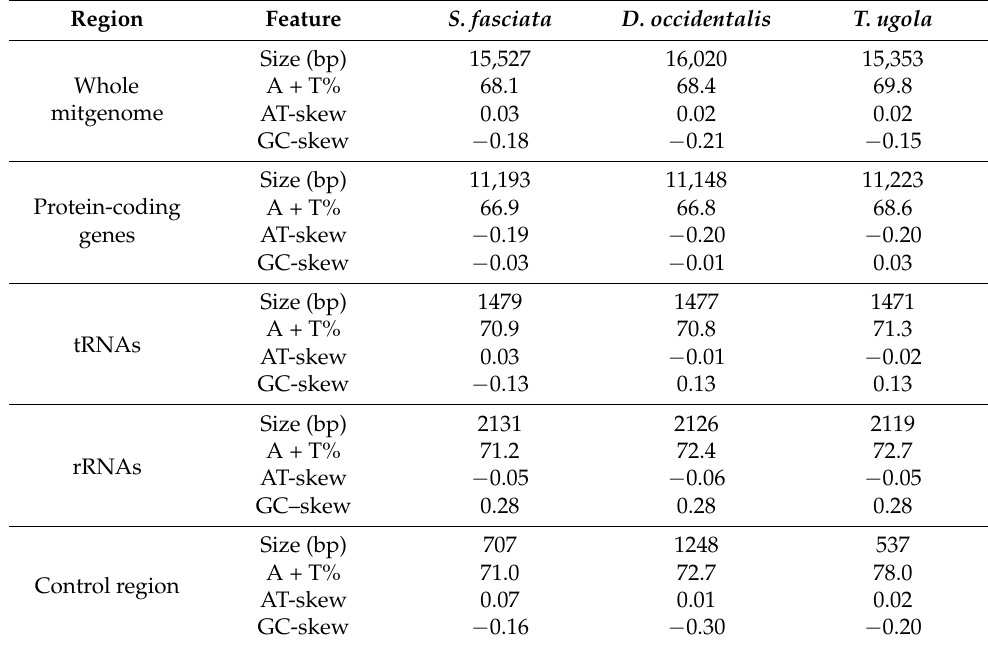
Table 2. Mitochondrial nucleotide composition in three taeniopterygid species.